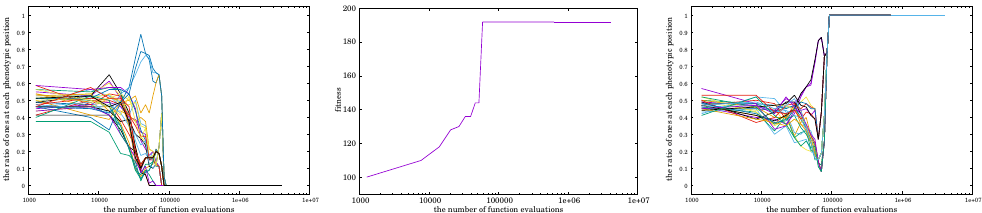
( a ) Convergence of the phenotypic values for HIFF ( (cid:96) = 32) when using the EDT with P =80 and T c = (cid:100) (cid:96) /2 (cid:101) .